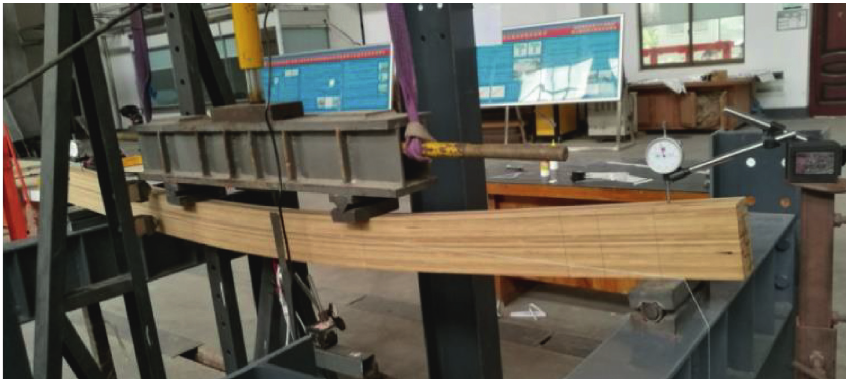
Figure 3: Failure modes of